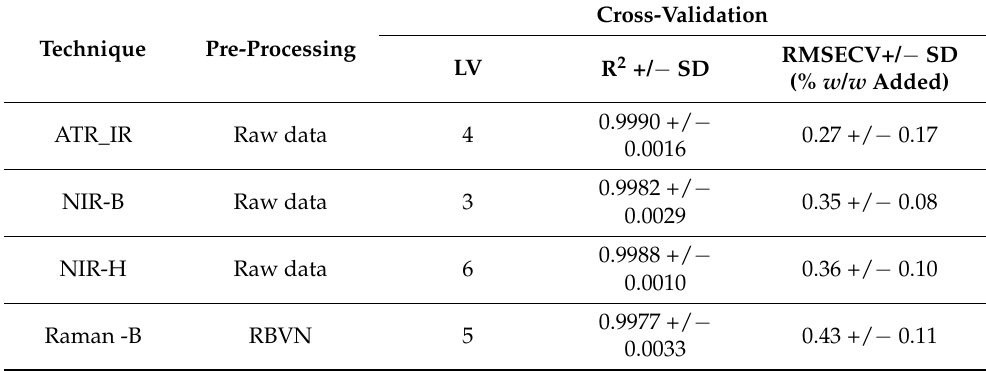
Table 1. PLSR outcome for the cross-validation (SET_2 and